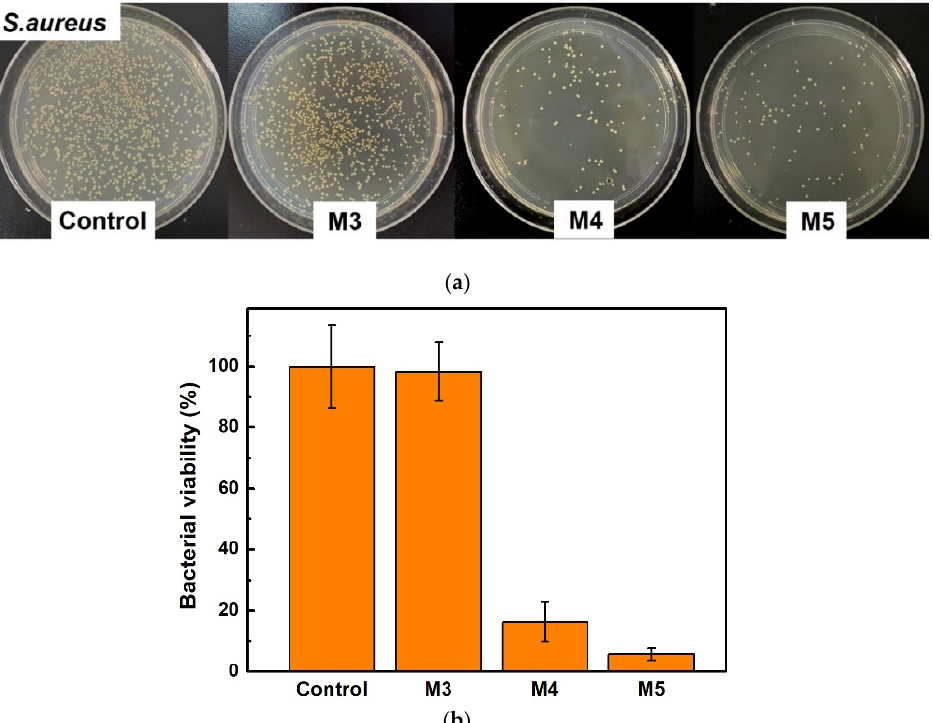
Figure 6. ( a ) Photographs and ( b ) the bacterial viabilities of the membranes M3, M4, and M5 against S. aureus